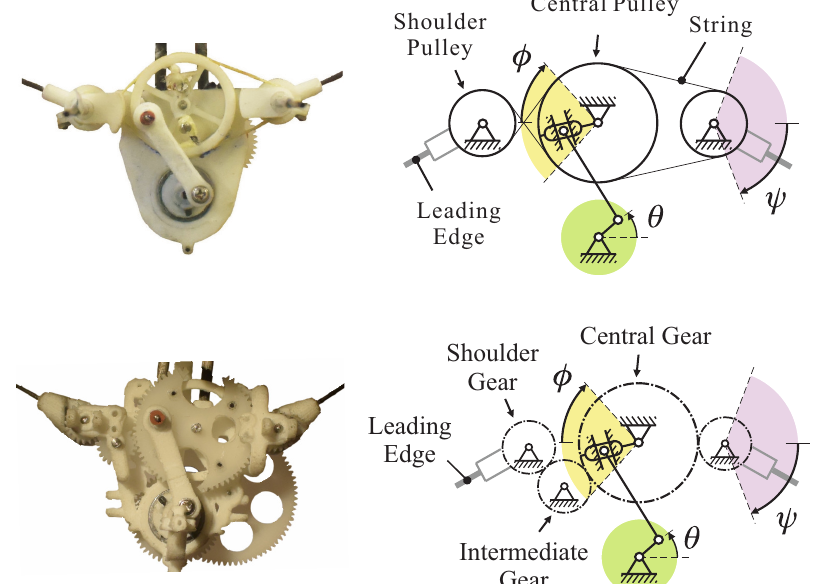
Figure 2. Evolution of the transmission mechanism of the COLIBRI robot. Top : string transmission. Bottom : gear transmission.